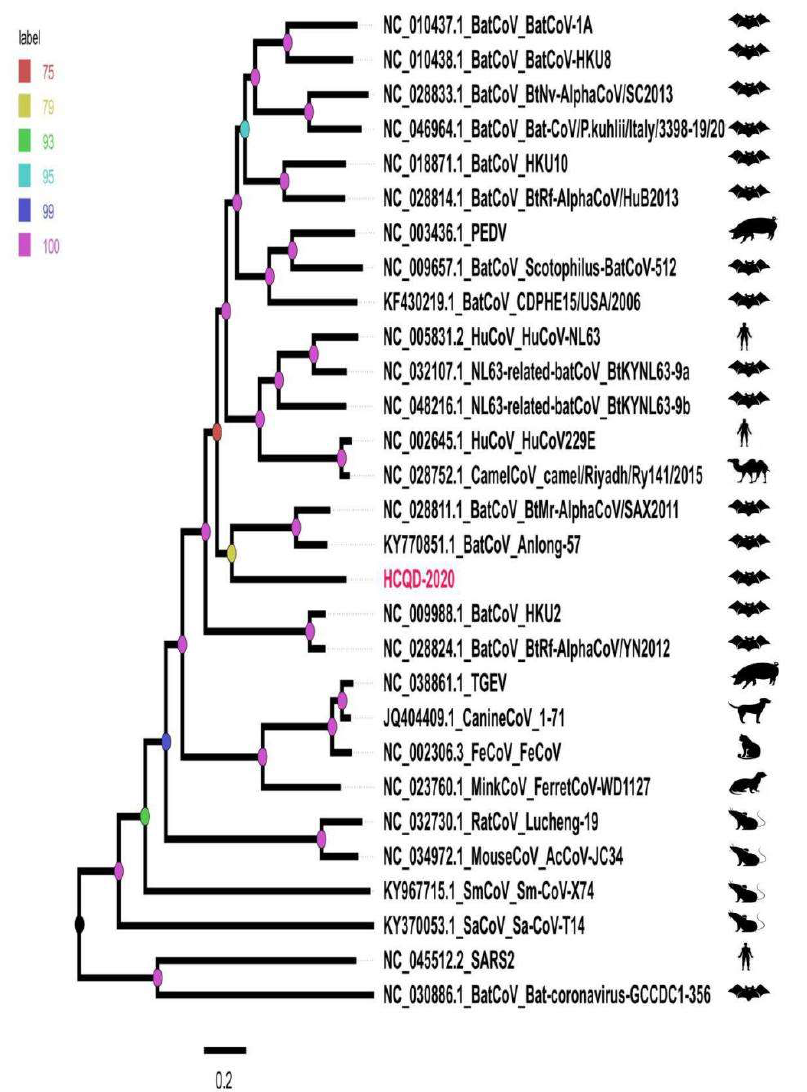
Figure 4. Phylogenetic tree representing the relationship among species and their hosts in the Alphacorona genus constructed from the whole-genome sequence. SARS-CoV2 and GCCDC1-356 belonging to Betacoronavirus were used as out group. The present strain is highlighted in red. The color of label represented the approximate bootstrap value in each node.